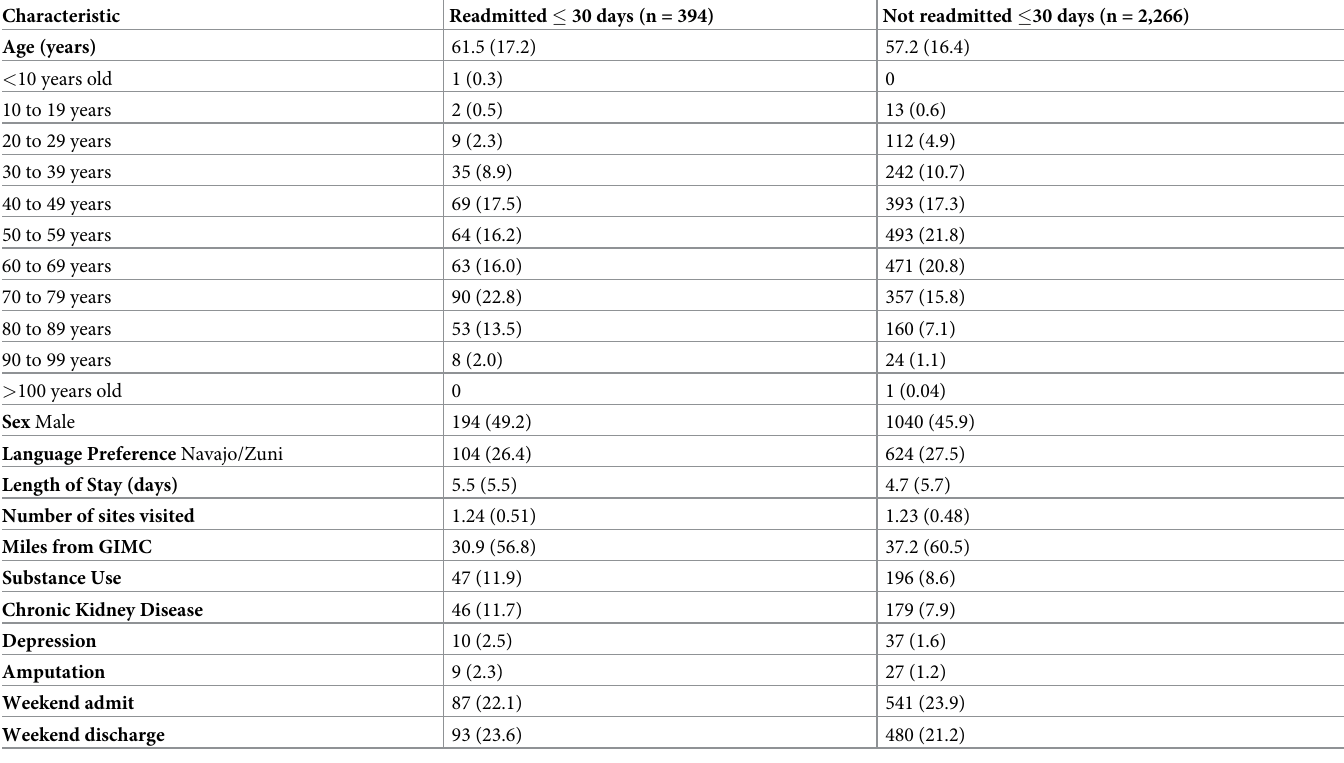
Table 1. Baseline characteristics and missing data for American Indian patients with diabetes admitted to GIMC between 2009 and 2016. Characteristic